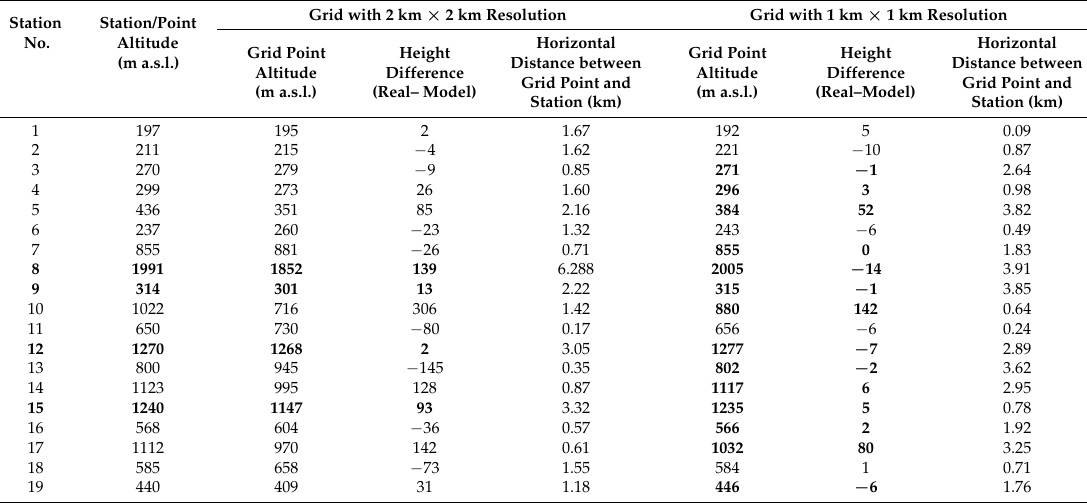
Table 4. Comparison of altitudes of meteorological stations/measurement points used in the study and horizontal distances between grid points and stations for AROME CMC 2 km and HARMONIE-AROME (both with 2 km × 2 km resolution) and for AROME CMC 1 km and ALARO NH (with 1 km × 1 km